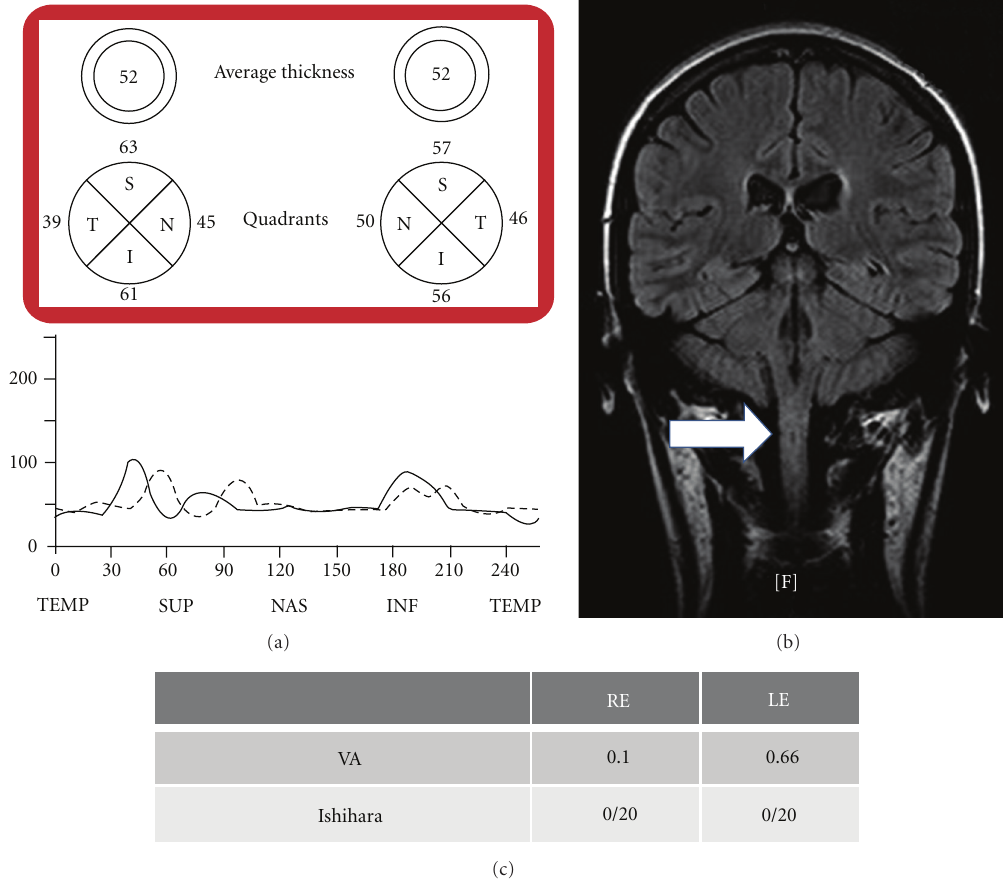
Figure 5: Teenager diagnosed of neuromyelitis optica who has su ff ered bilateral optic neuritis as well as myelitis. Although normative data are not available, the retinal nerve fiber layer thickness measured with optical coherence tomography is extremely